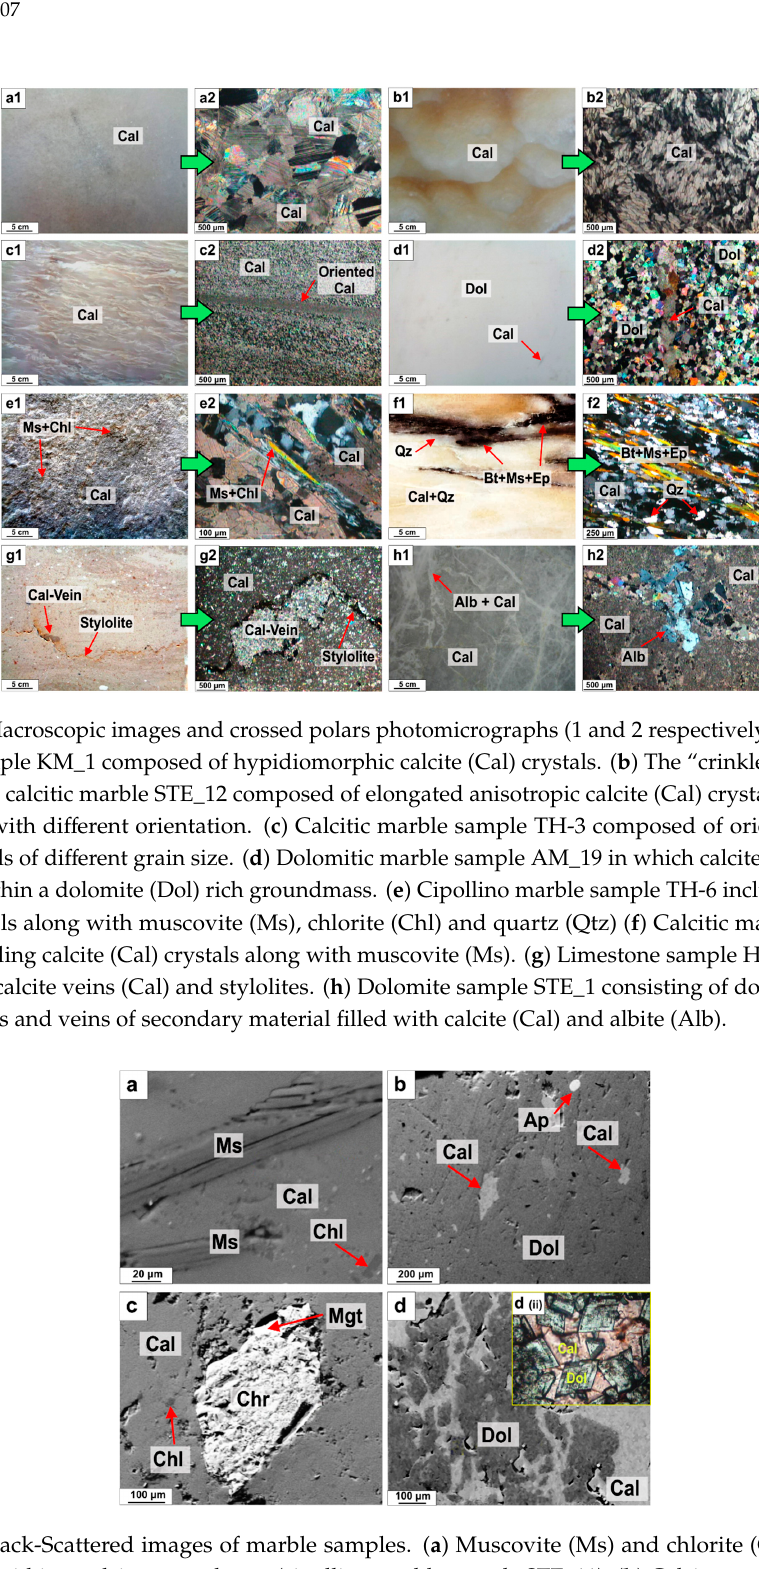
Figure 3. Back-Scattered images of marble samples. ( a ) Muscovite (Ms) and chlorite (Chl) crystals developed within a calcite groundmass (cipollino marble sample STE_11); ( b ) Calcite crystal (Cal) and apatite (Ap) within the dolomitic (Dol) rich groundmass (dolomitic marble AM_3); ( c ) Chromite (Chr) altered to magnetite within a calcitic (Cal) rich groundmass of cipollino marble TH-6; ( d ) Dolomitic rock (sample STE_14) that includes both dolomite (Dol) and calcite (Cal) intergrown crystals. f(ii). Inserted photomicrograph of the same dolomitic rock sample (sample STE_14), in which alizarin red was applied upon a thin section. Red colour shows calcite crystals, whereas pale blue the dolomite crystals.